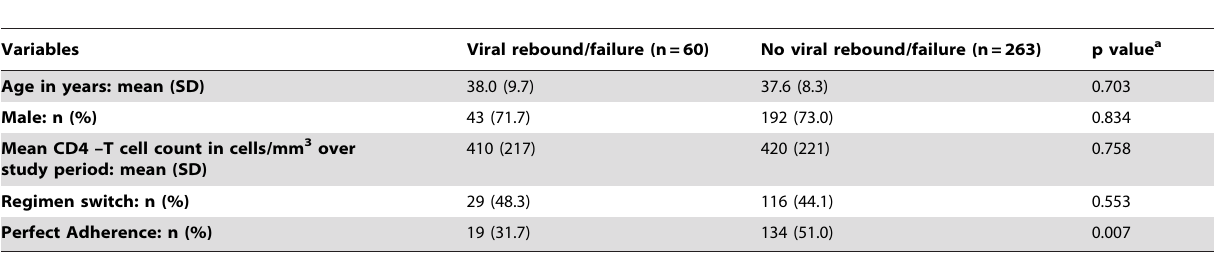
Table 3. Viral rebound/failure and its associations with patients’ demographic, clinical, and behavioural parameters.